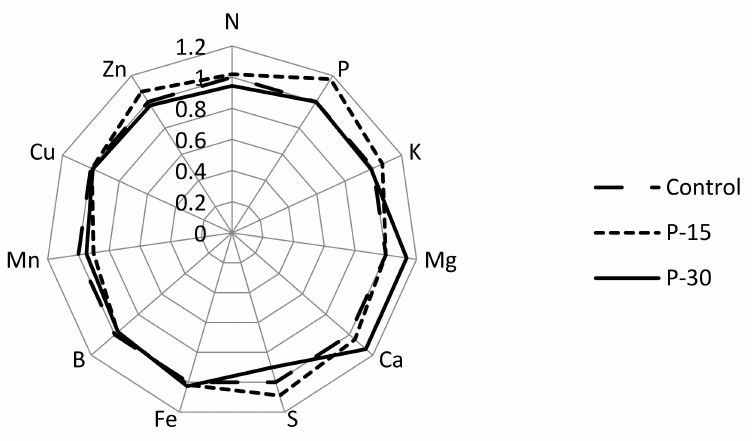
Figure 6. The concentration of mineral components in pepper leaves normalized to the values in control content as radar plots under di ff erent PP combinations (average of two